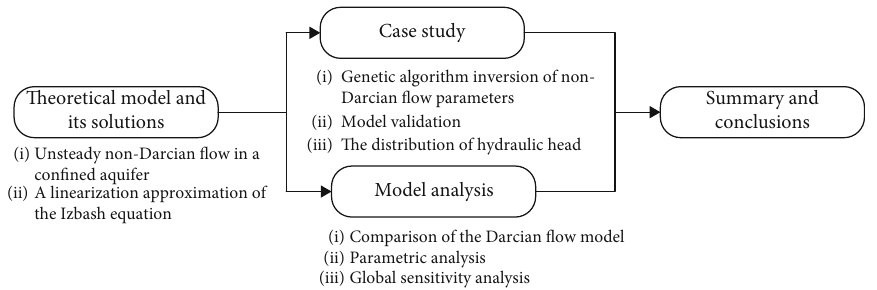
Figure 1: The general sketch of this